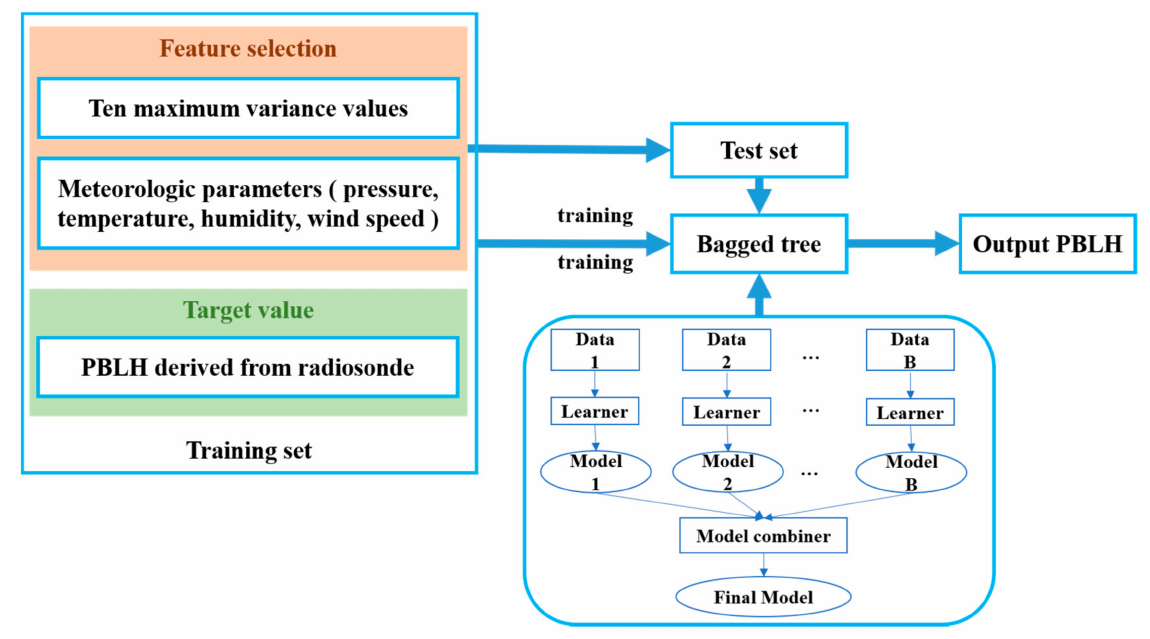
Figure 2. Flowchart of BT to determine the PBLH by integrating the MPL lidar profiles and meteoro- logical